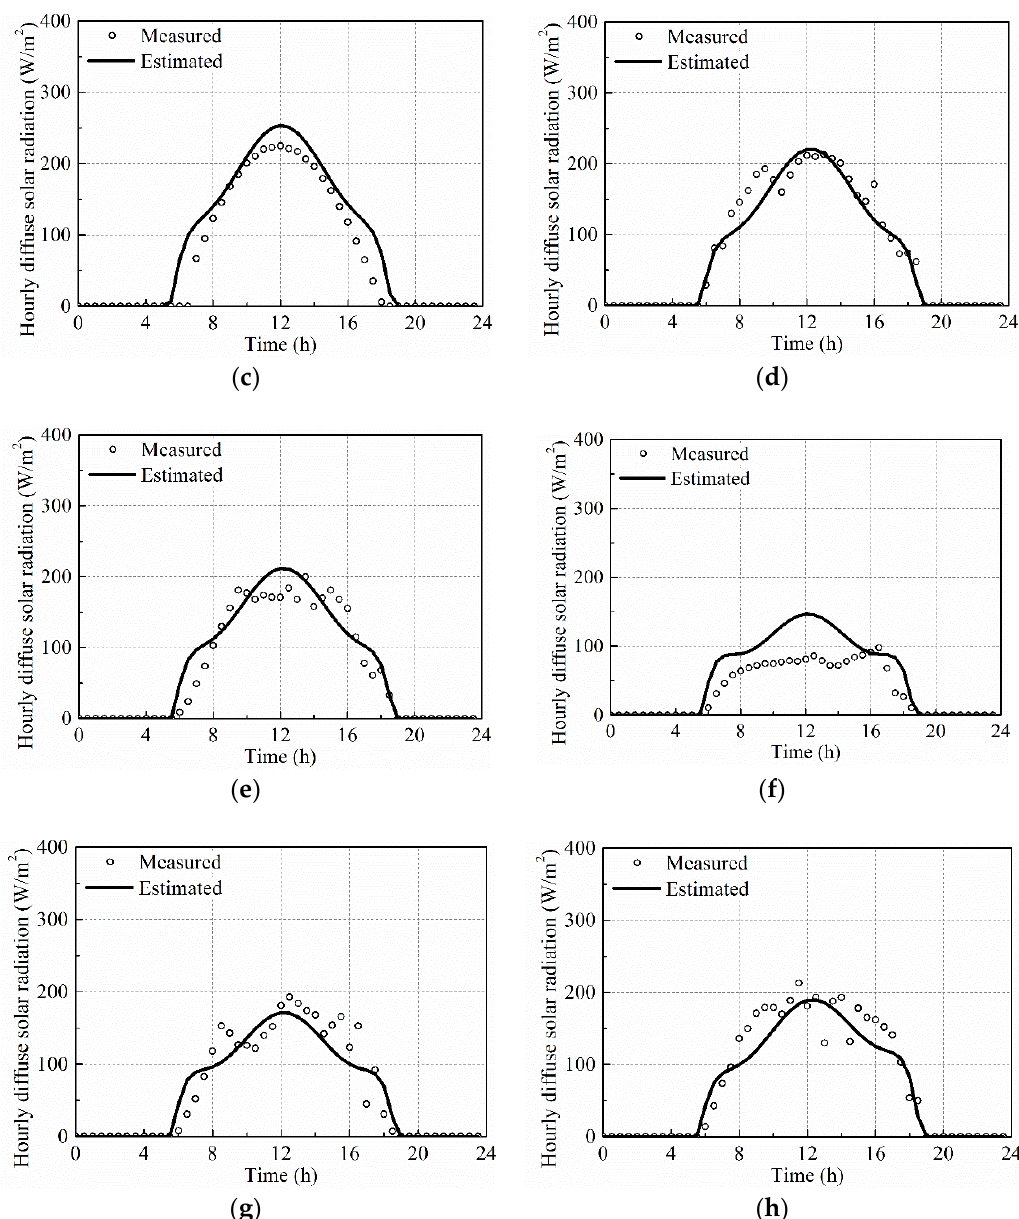
Figure 7. Comparison between measured and estimated hourly diffuse solar radiation curves for eight cities in Fujian: ( a ) Fu’an (10 August 2016); ( b ) Jian’ou (7 August 2016); ( c ) Fuzhou (2 August 2010); ( d ) Ninghua (4 August 2016); ( e ) Zhangping (27 July 2016); ( f ) Anxi (2 August 2015); ( g ) Hua’an (30 July 2016); and ( h ) Zhangzhou (31 July 2014).